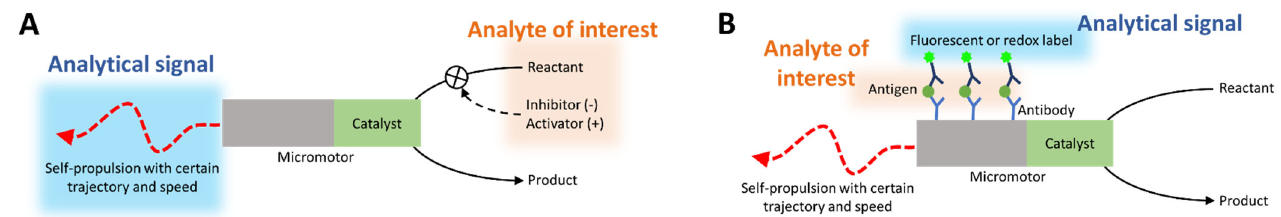
Figure 2. Two ways of using catalytic micromotors for sensing. ( A ) Fuel molecules (or species which inhibit/activate the catalytic process) are the analytes of interest and either the speed or the diffusion coefficient of the catalytic micromotors is the analytical signal; ( B ) The self-propulsion of the catalytic micromotors has the role of increasing mass transport within the investigated sample (by inducing flow of the solution and by moving through the solution). The catalytic micromotors carry classic biomolecule detection schemes (such as the “sandwich-type” detection scheme based on antibodies schematically shown here). Depending on the detection scheme, in this approach, the analytical signal is either optical or